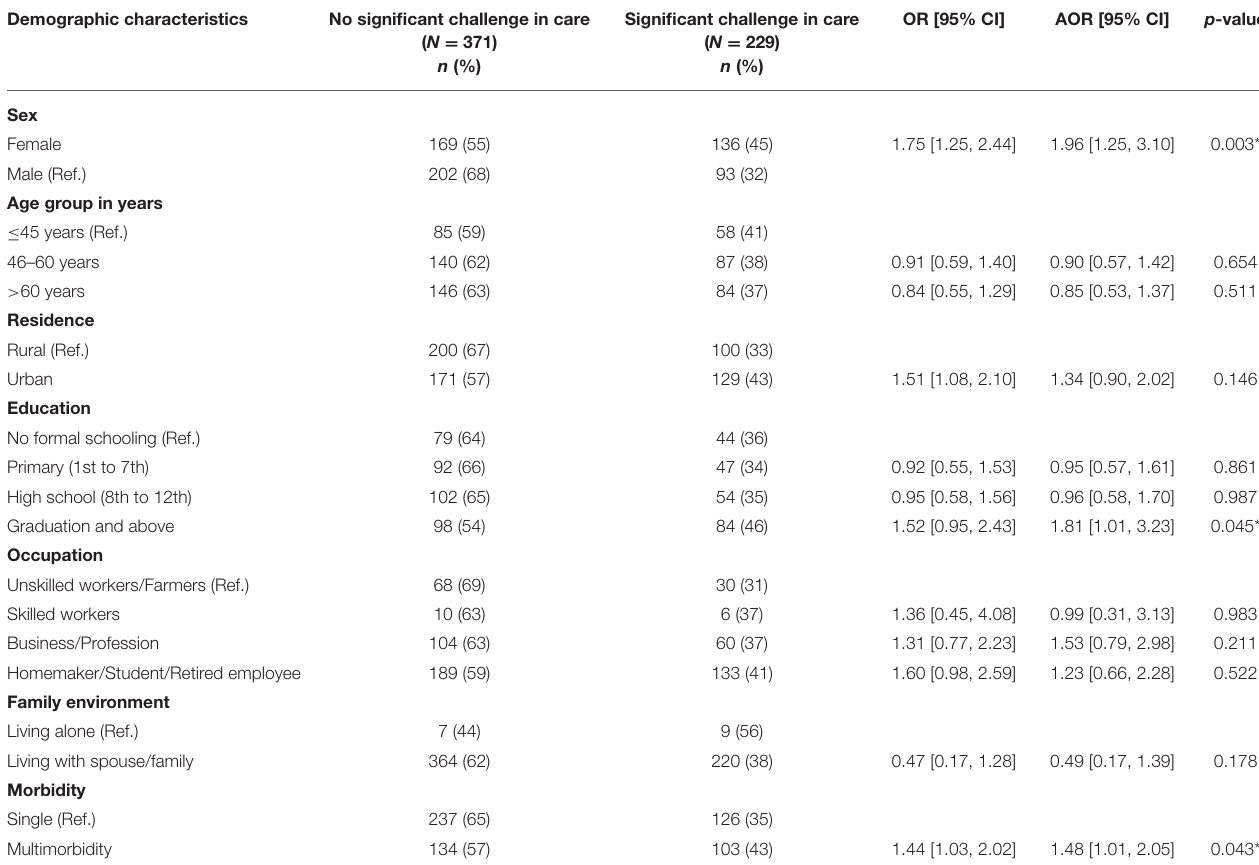
TABLE 3 | Association of socio-demographic characteristics and multimorbidity with care challenges. Demographic characteristics